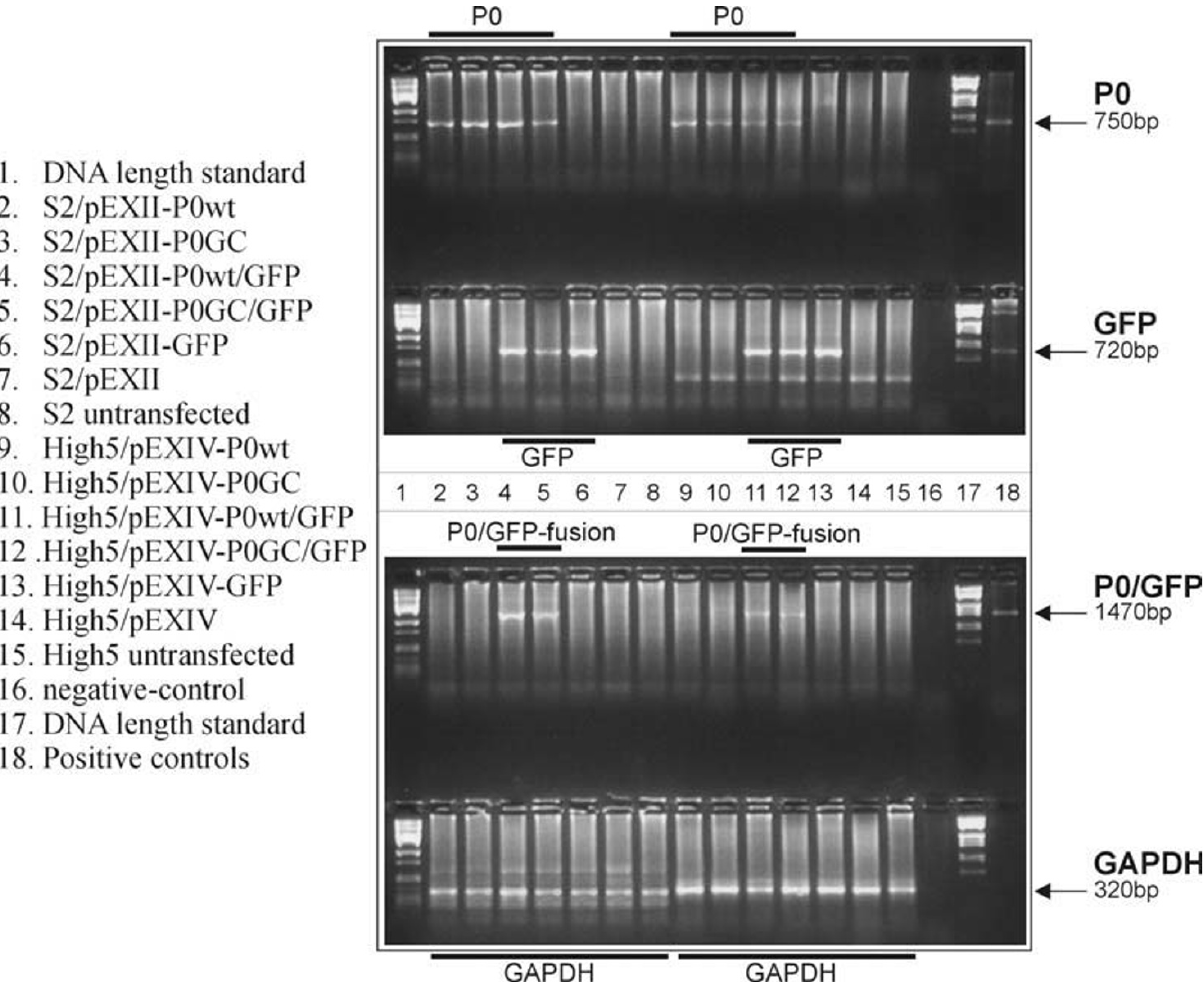
Figure 6 Semiquantitative determination of RNA in non transfected and transfected S2 and High5 insect cells by RT- PCR. The respective RT-PCR products derived from the different transfectants revealed the expected sizes as indicated by the positive controls: wild type P0, GFP, P0-GFP and GAPDH. The GAPDH products indicate similar RNA amounts for each experimental